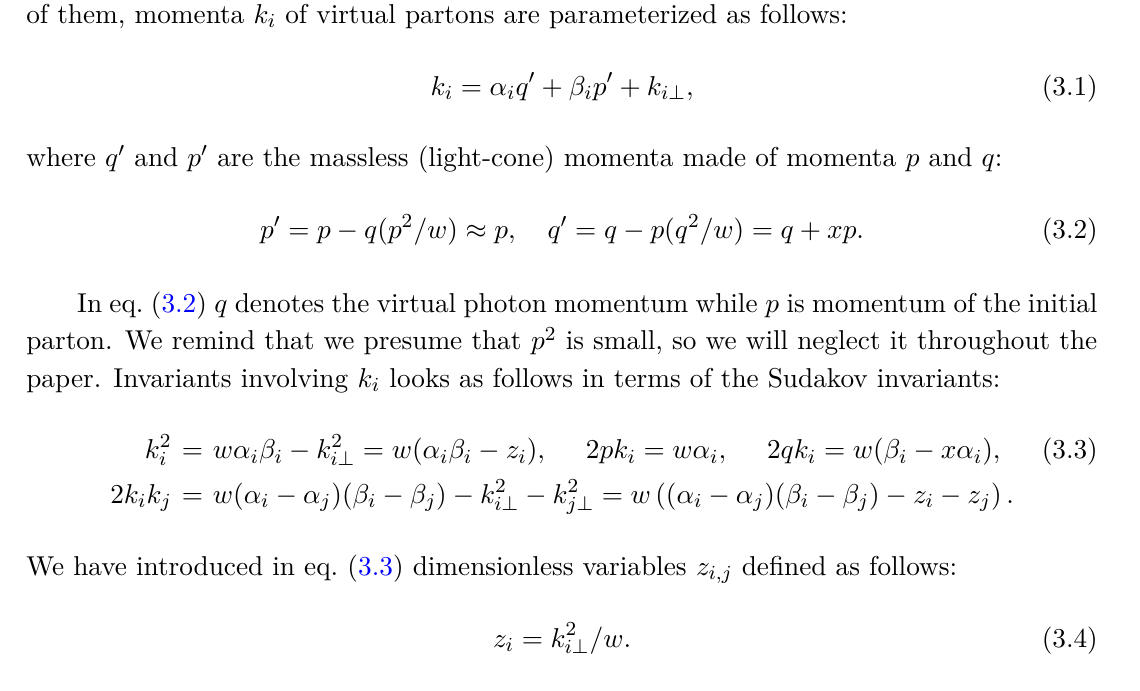
, F ( q,g ) and F ( q,g ) in the second-loop approximation. 1 2 L